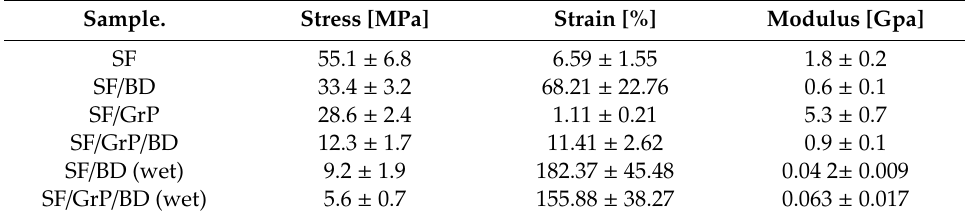
Table 1. Dry and wet mechanical properties of SF, SF / BD, SF / GrP, and SF / GrP / BD films. Sample.